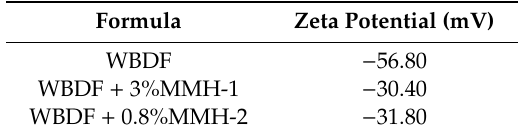
Table 5. E ff ect of di ff erent types of MMH on the zeta potential of filtrate.